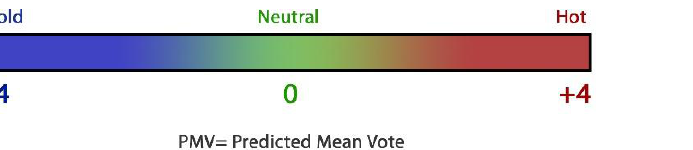
Figure 1. Classification of PMV levels based on nine comfort scales. Image generated by the author from reference [38].